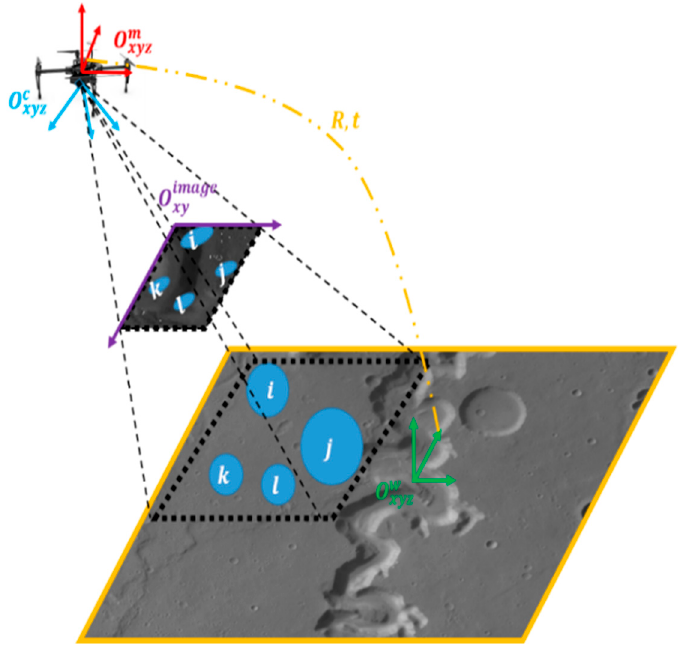
Figure 9. World coordinate system O w xyz , machine coordinate system O m xyz , camera coordinate system O c xyz , and image coordinate system O image xy . Pose is estimated from four recognized craters i , j , k , and l , which involves the rotation matrix R and translation matrix t .